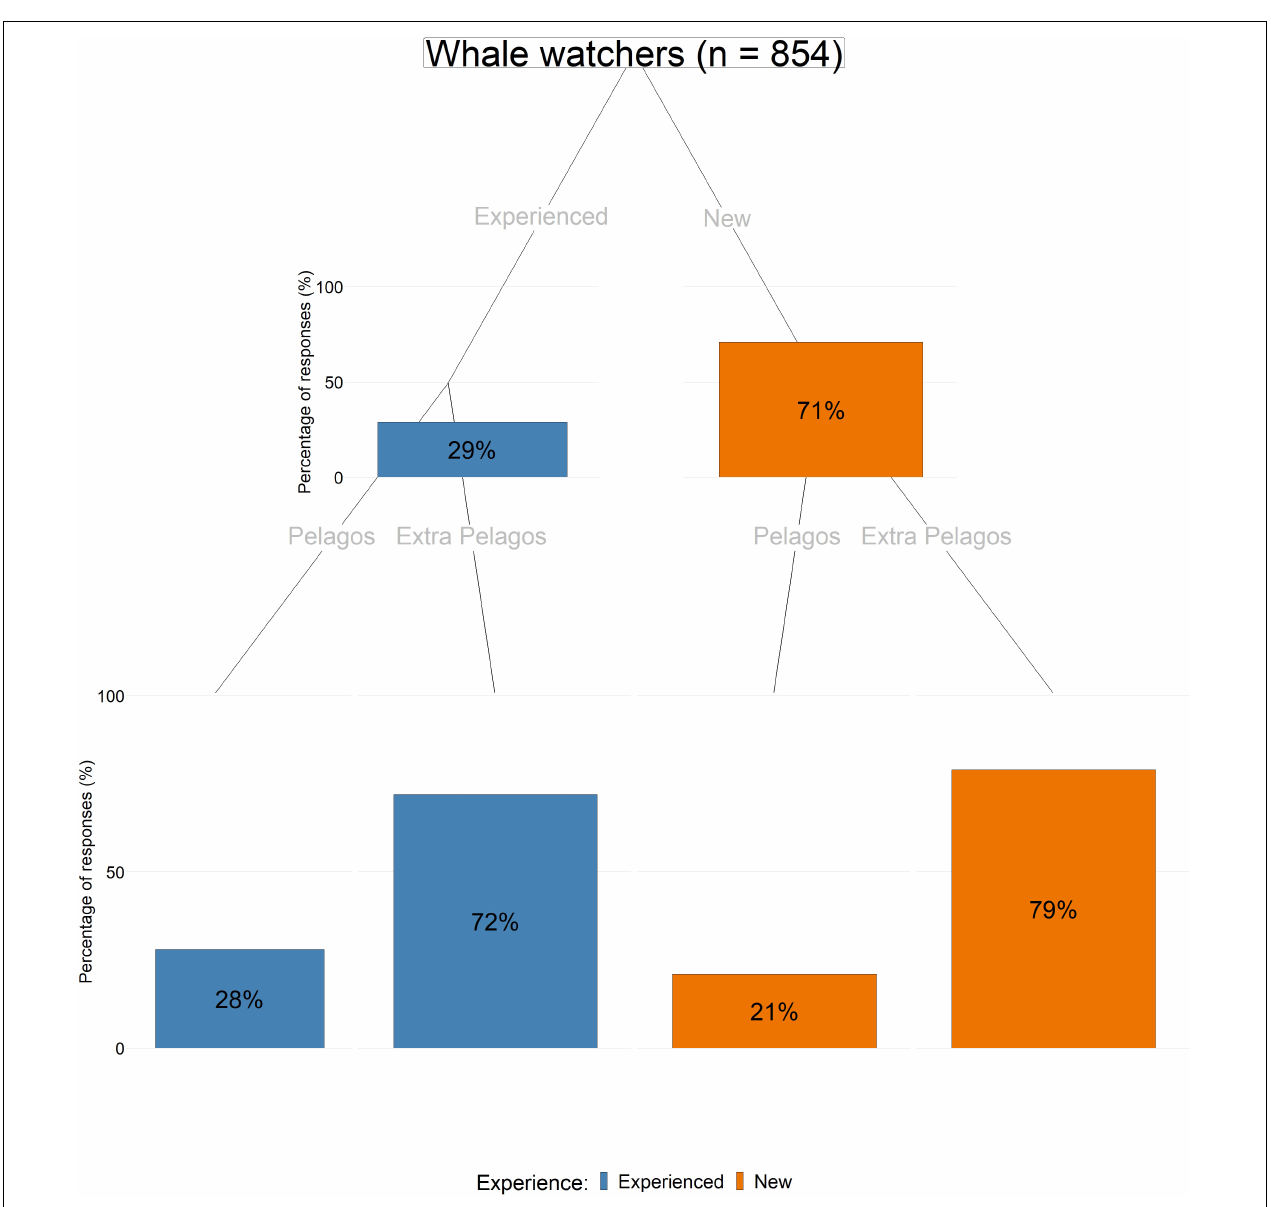
FIGURE 2 | Percentages of Experienced and New whale watchers, overall (upper graph) and considering the origin (lower graph) .